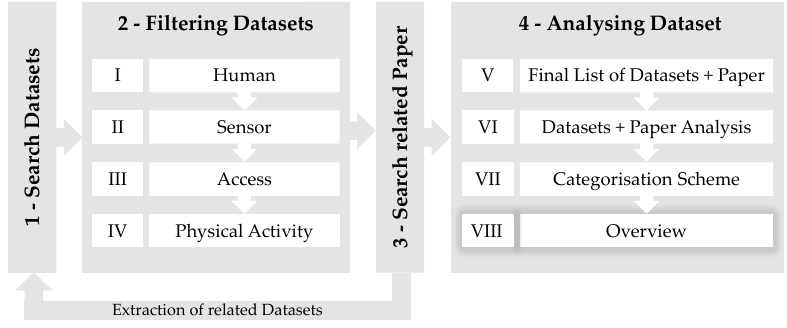
Figure A1. Method of the dataset